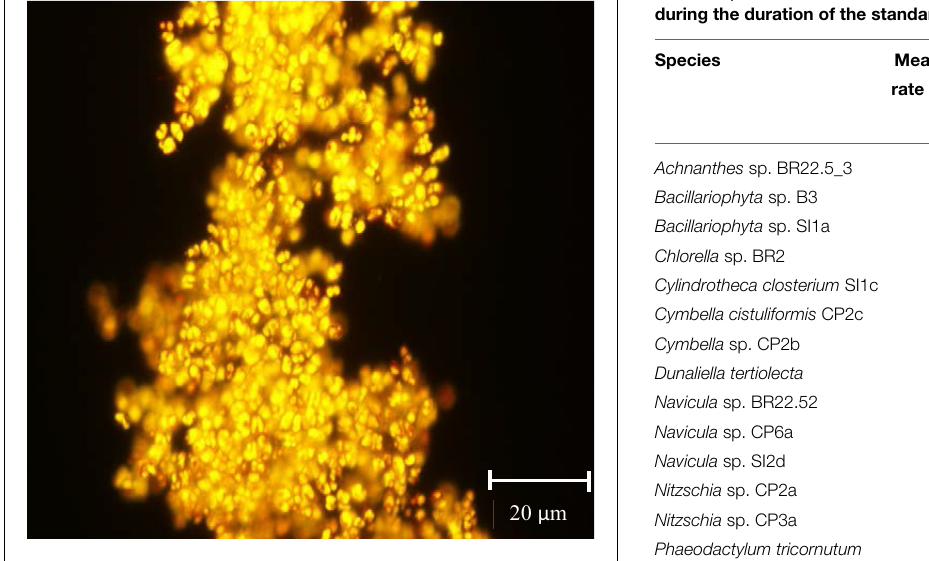
FIGURE 1 | Cymbella sp. CP2b after Nile red staining under fluorescence microscopy. Yellow droplets show lipid containing triacylglycerides and orange droplets show autofluorescence from chlorophyll. Cymbella sp. CP2b displayed fast growth rates and one of the highest lipid productivities (4.51 µ g mL − 1 day − 1 ).